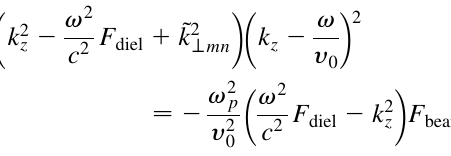
FIG. 1. (Color) Configuration for a 30-keV, 220-GHz TWT structure and rf electric field distributions from analytic theory. (a) shows the cross section of the interaction region that is a piece of symmetric three-zone rectangular dielectric-loaded waveguide. (b) shows the normalized electric field profiles for mode, where E and E are mirror symmetric with LSM x z 21 (cid:3) 38 : 6 kV = m and E (cid:5) center (cid:6) (cid:3) respect to the y - z plane. E x max z 9 : 2 kV = m for a 1-W rf flowing power.